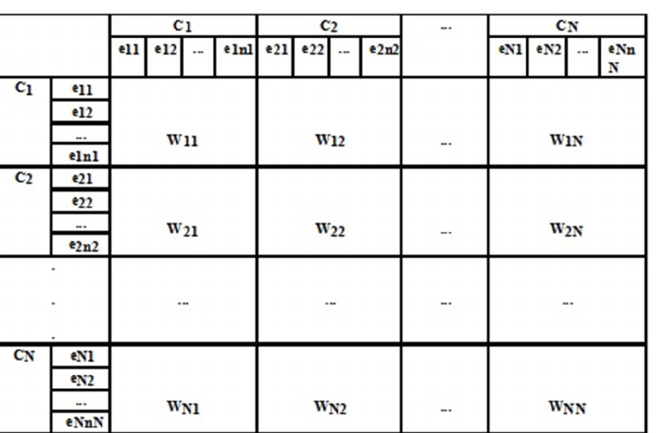
Table 2. Random consistency index.